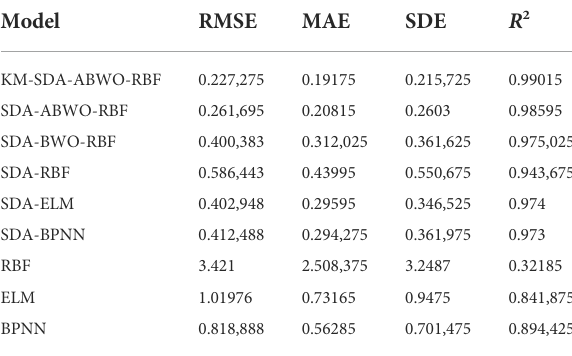
TABLE 3 Average value of RMSE, MAE, SDE and R 2 in four